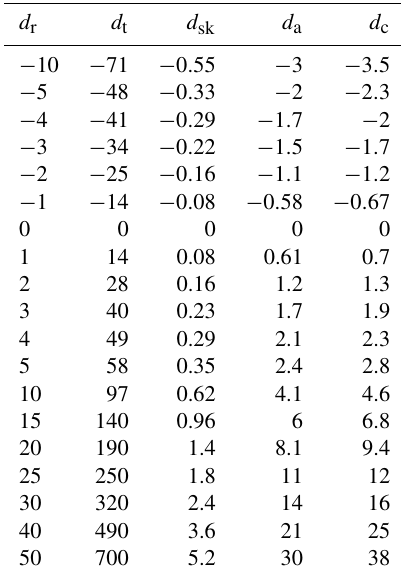
Figure 8. Left: filtered U–Pb age spectra for the test data, removing the 50% most discordant grains according to five discordance fil- ters reviewed in this paper, shown as a kernel density estimate with 50Myr bandwidth. The complete (unfiltered) dataset is shown in grey. Right: quantile–quantile plots comparing the filtered and un- filtered datasets. KS: the Kolmogorov–Smirnov statistic. The rela- tive age filter ( d r ) introduces the greatest and the concordia distance ( d c ) the smallest bias.